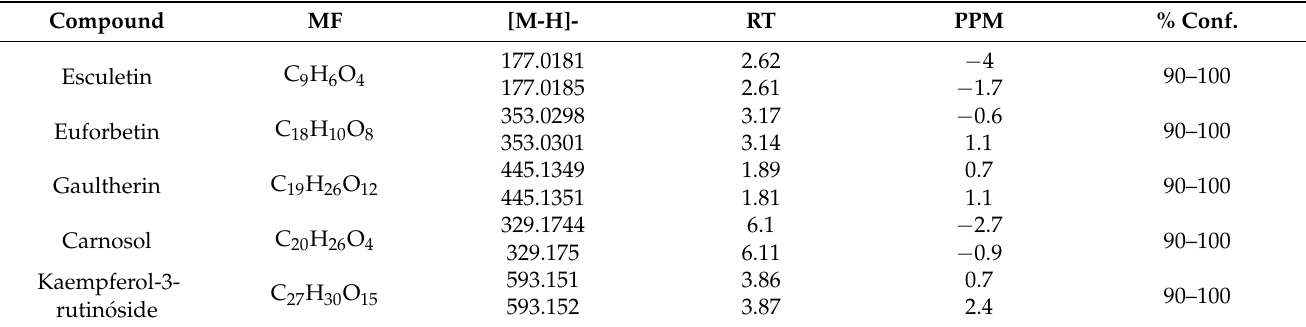
Table 2. Identification of bioactive compounds in the ethanolic extract from the defatted flour of Euphorbia lathyris . Compound MF [M-H]- RT PPM % Conf.